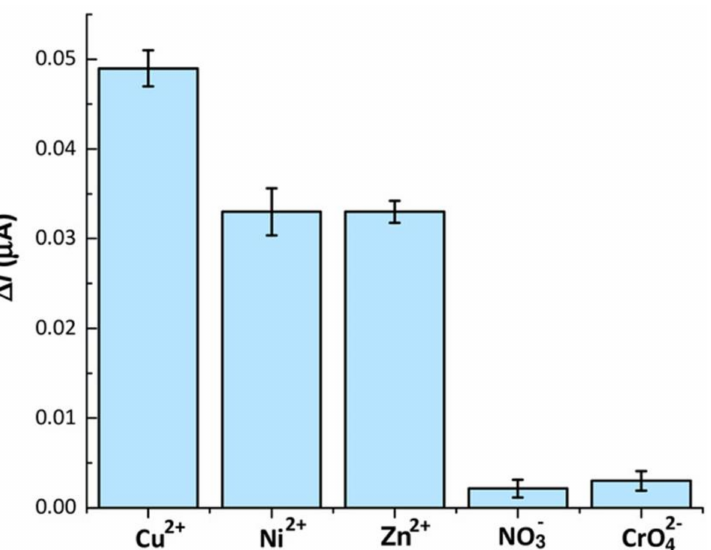
Figure 11. Selectivity studied of nanoIIPs to 1.9 nM of Cu 2+ , Ni 2+ , Zn 2+ , NO 3 − and CrO 42 − . Repro- duced with permission from [86], ©